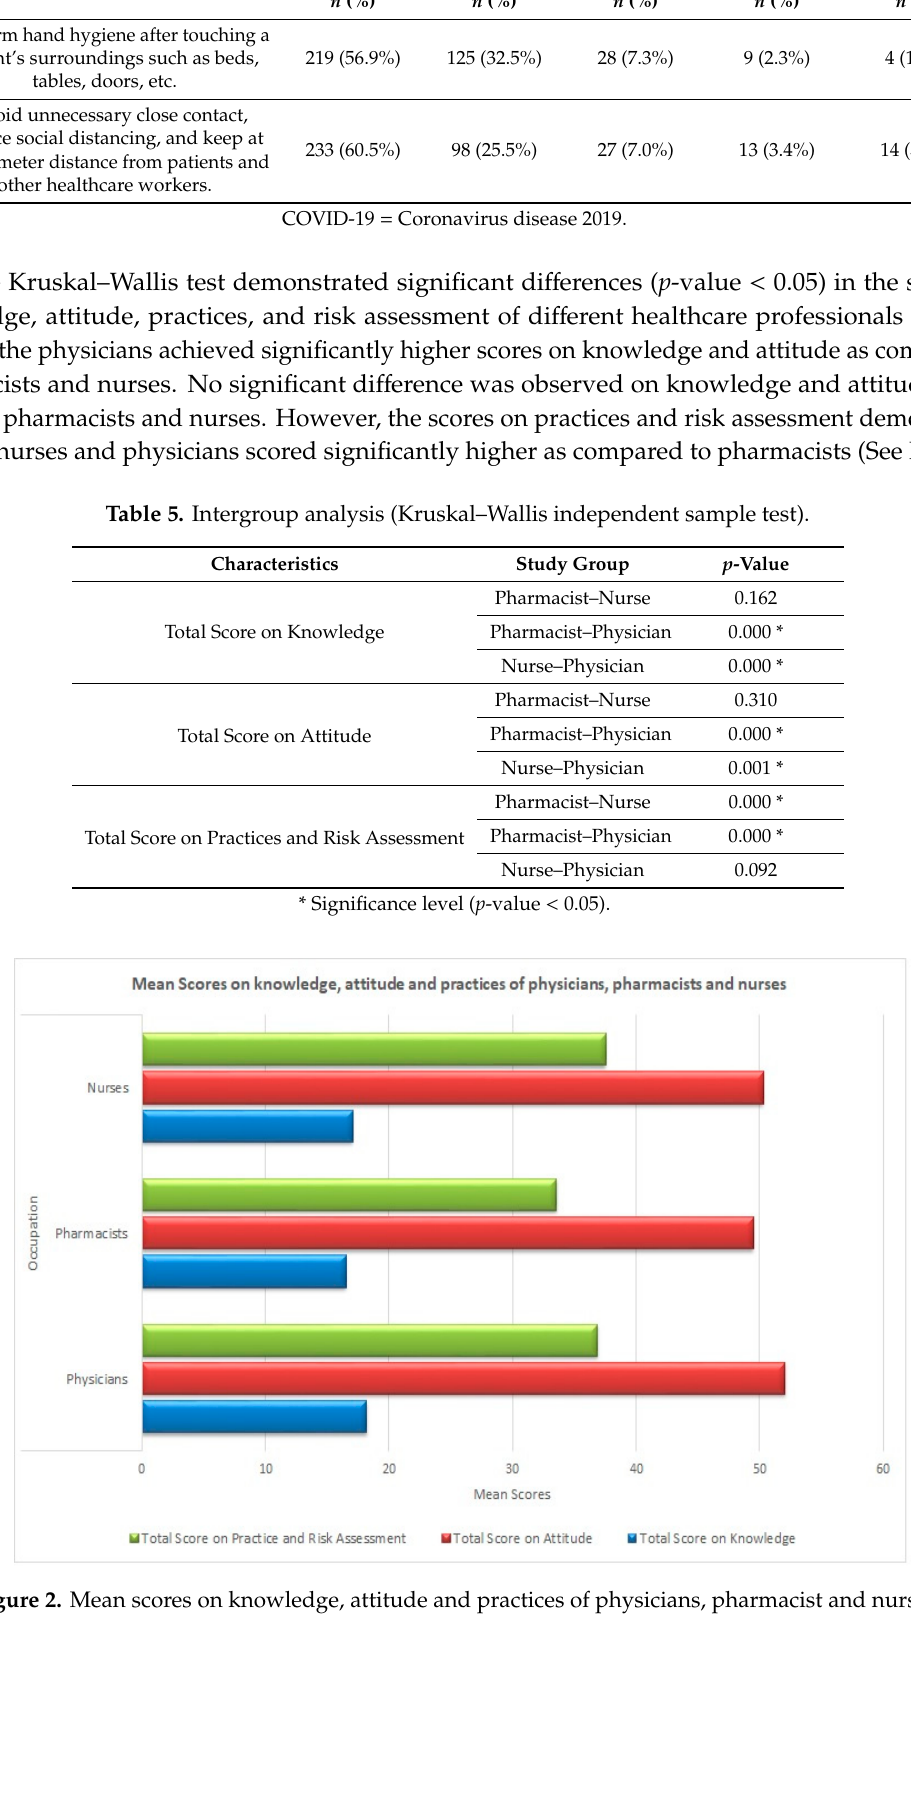
Table 6. Intergroup analysis. (Jonckheere–Terpstra trend test) Study Group